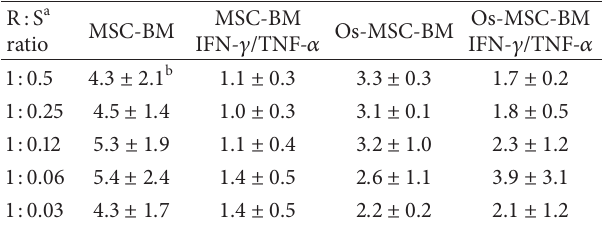
Table 2: MSC from AT after osteodifferentiation and licensing by IFN- 𝛾 and TNF- 𝛼 do not induce PBMC proliferation in allogenic